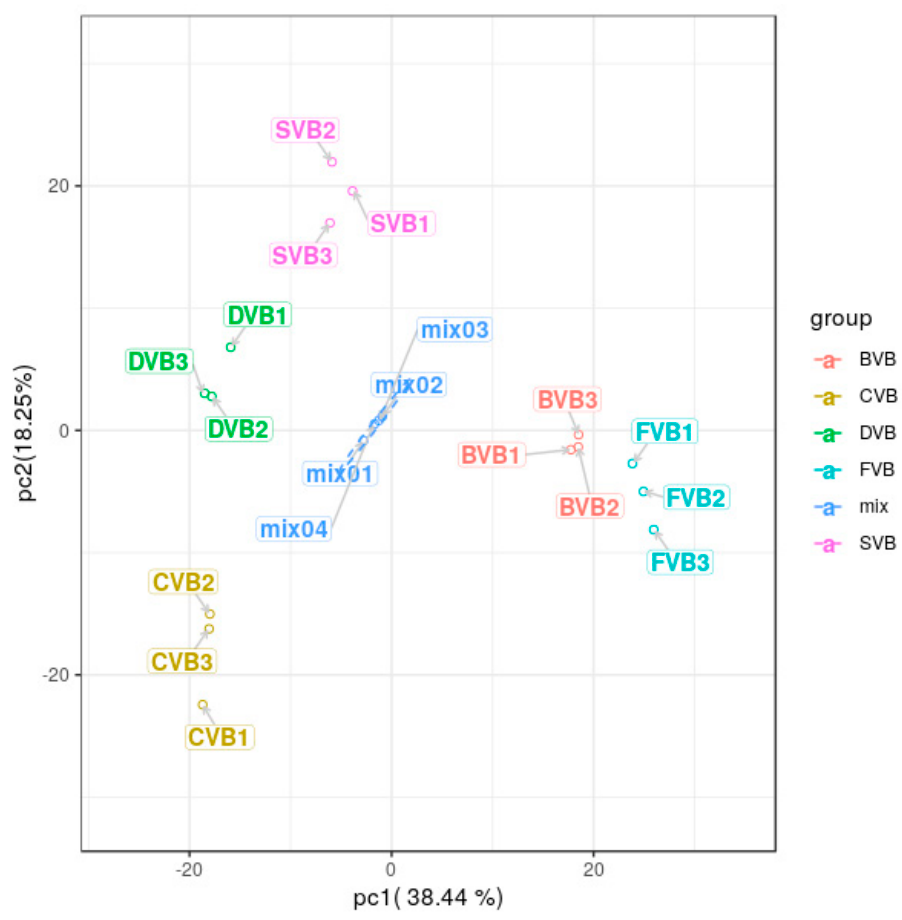
Figure 2. Principal component analysis (PCA) scores of vanilla beans during the curing process and the quality control sample. FVB: Fresh vanilla bean; BVB: Blanched vanilla bean; SVB: Sweating vanilla bean; DVB: Drying vanilla bean; CVB: Cured vanilla bean; mix: Mixture of extract of vanilla samples.